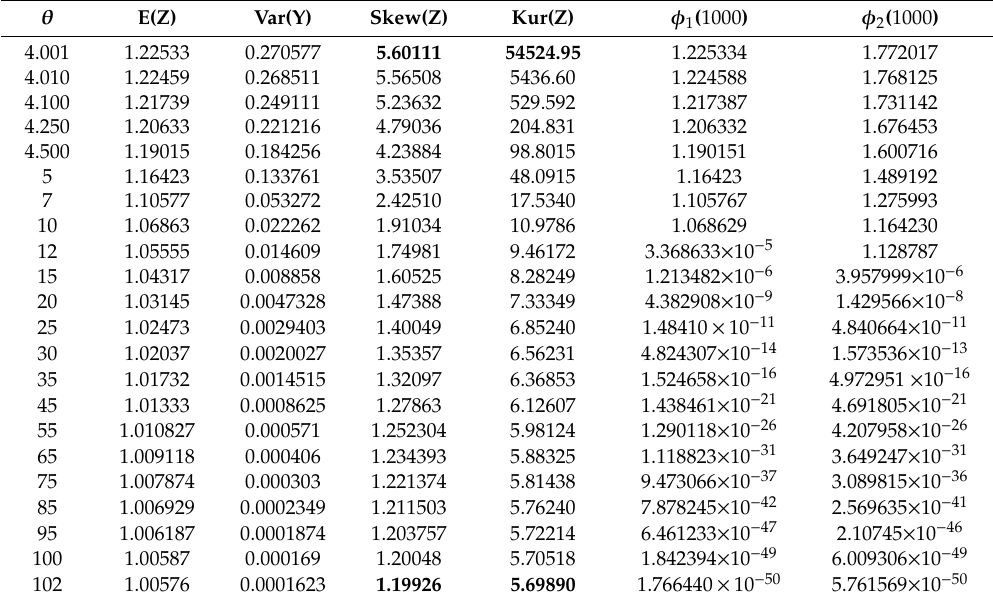
Table 2. E(Z), Var(Z), Skew(Z) and Kur(Z) of the RW